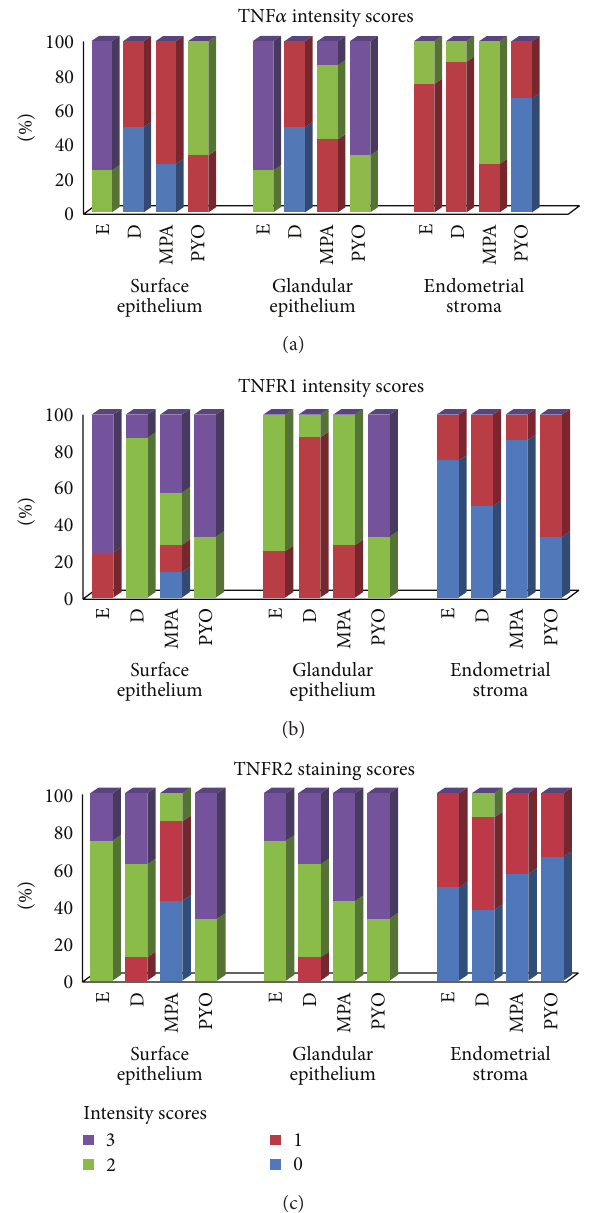
Figure 9: Graphic illustration of the relative intensity scores for TNF 𝛼 , TNFR1, and TNFR2 in different compartments of the endo- metria of cats collected at estrus (E, 𝑛 = 7 ) and diestrus (D, 𝑛 = 8 ) from cats that had been treated with a P 4 derivative analog, medroxyprogesterone acetate (MPA, 𝑛 = 5 ), or cats presenting the clinical symptoms of pyometra (PYO, 𝑛 = 3